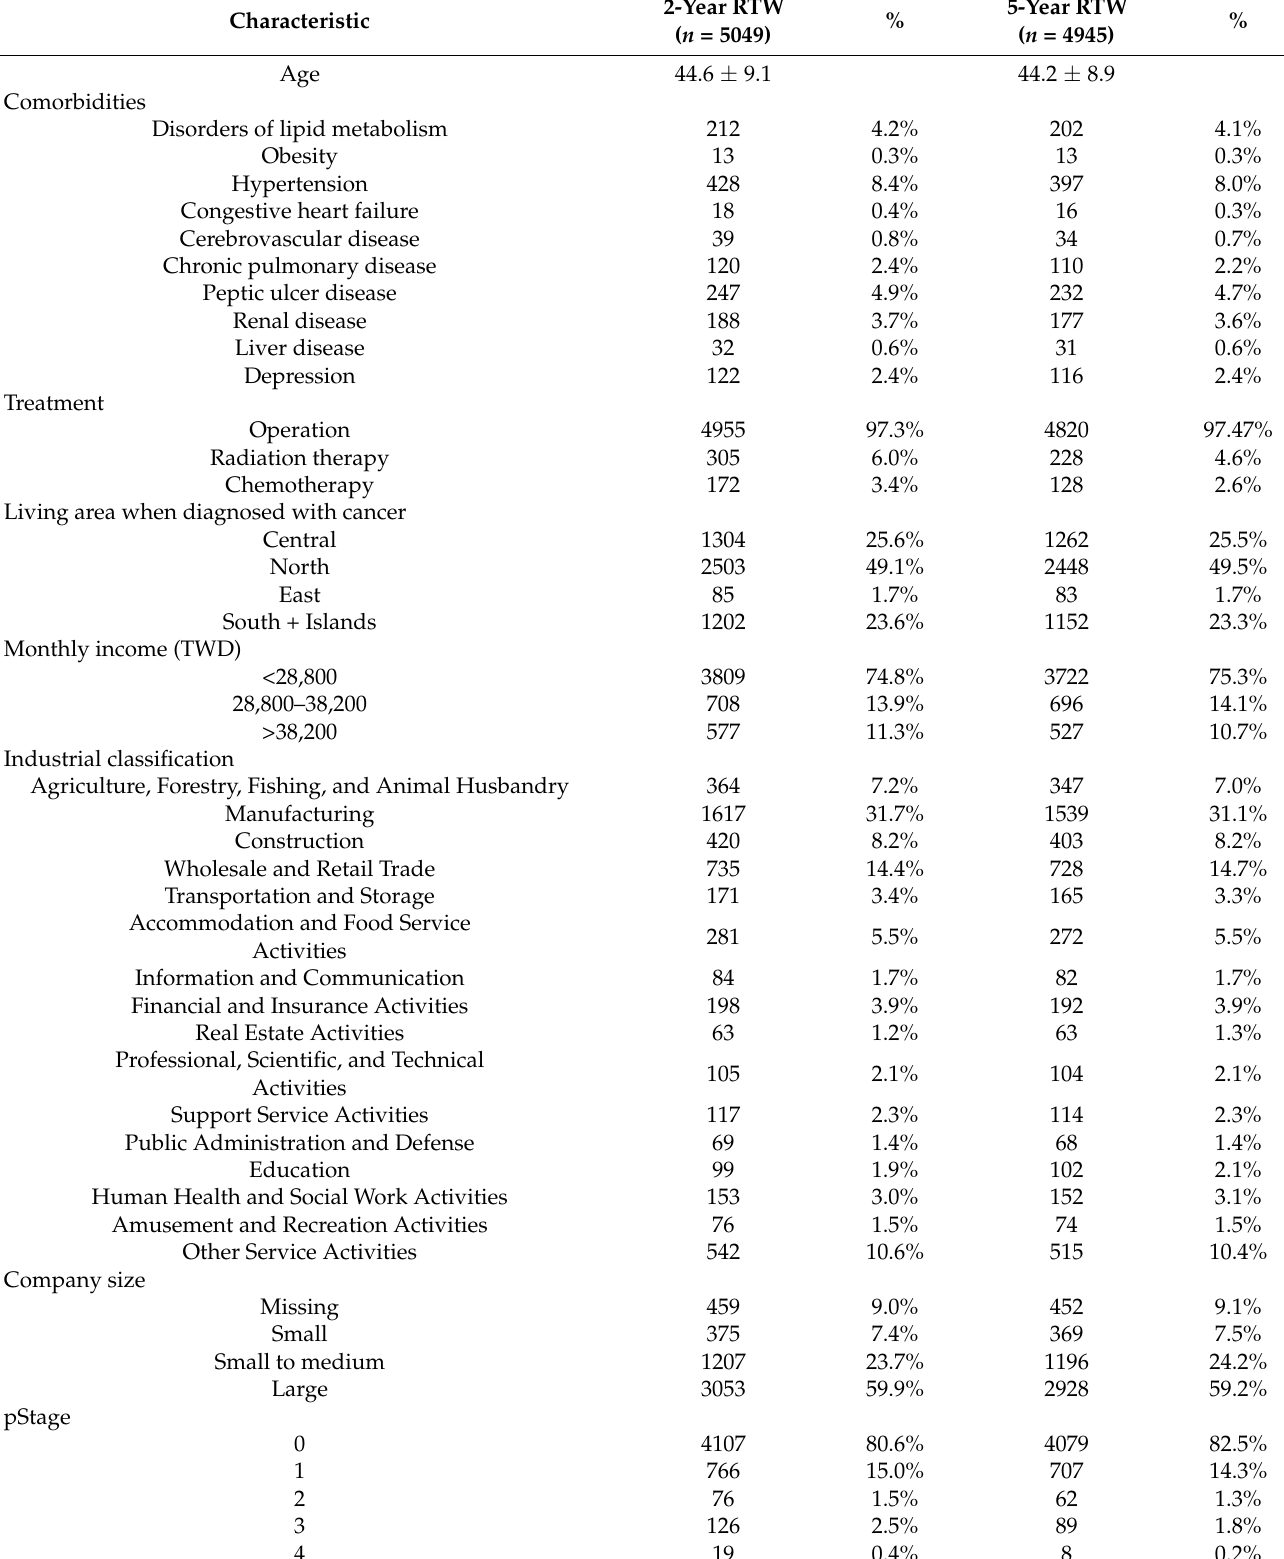
Table 2. Demographic data of RTW individuals from 2nd and 5th year of cervical cancer